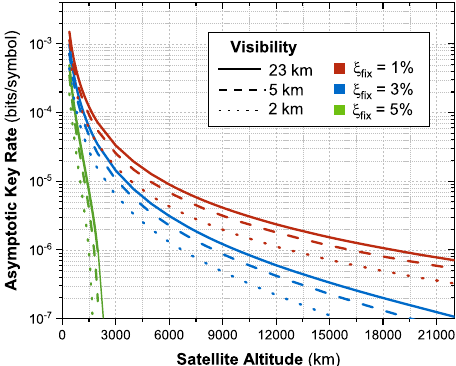
Fig. 12 Impact of the sky visibility on key rate. Comparison of secret key rate for different values of sky visibility at the three excess noise